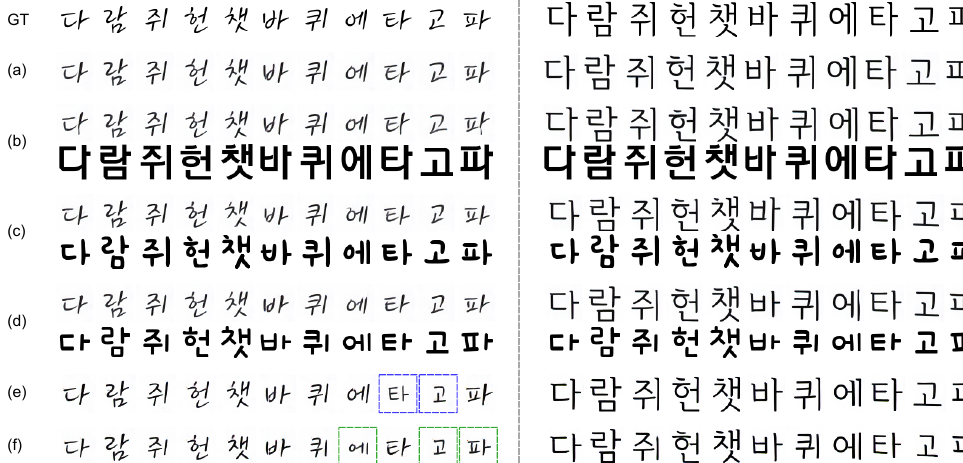
Figure 7. Examples of the generated images for unseen font. GT: image of ground truth font. ( a ): results with real stack, ( b – d ): results with hallucinated stack for content reference (upper row) and content images (lower row), ( e ): results with hallucinated stack for style reference, ( f ): results with hallucinated stack for both content and style